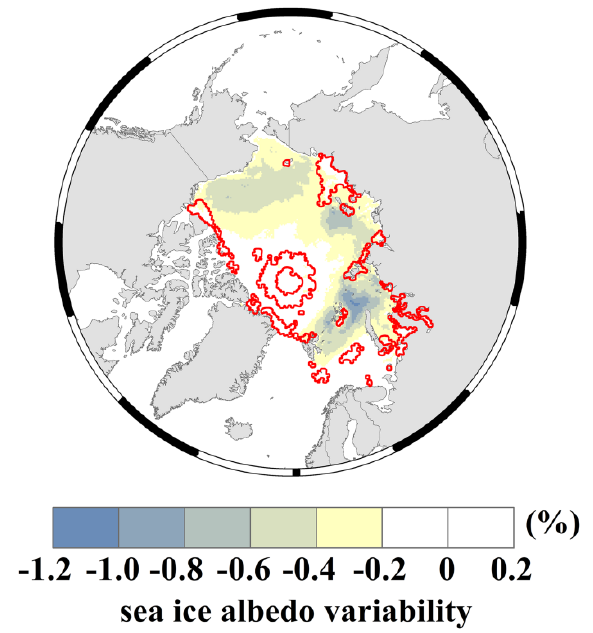
Figure 12. The spatial trends of sea ice albedo in summer from 1982 to 2018. Sea ice loss and Arctic surface albedo decline resulted in an imbalance of the atmospheric energy budget. Larger incoming insolation (solar radiation) is balanced by increased OLR via warming the atmosphere. OLR is an indicator of heat released from the ocean through longwave radiation. The negative correlation between SIT (SIA) and OLR in the Barents–Kara Seas was the strongest compared to the Atlantic and Pacific sectors, due to the rather large extent of the ice-free open sea, mostly in the Barents–Kara Seas. The heat released from the ocean to the atmosphere warmed the atmosphere and decreased the sea ice cover. There was a significant positive correlation between OLR and SAT (SST); the correlation relationship for SAT was stronger than SST (Tables 4–6).